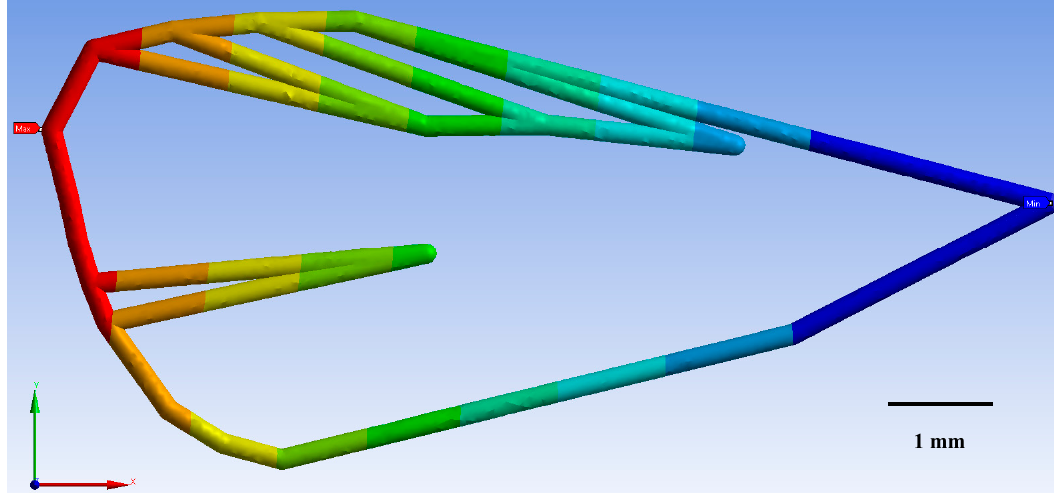
Figure 6. Codling moth from the ecological populations exhibited a maximum deformation (red area) of 0.0118 mm around landmark 8 (Figure 1) for a maximum wind speed of 4.2 m/s − 1 . The minimal deformation of 0.0013 mm was concentrated around landmark 17 (light blue area on figure).